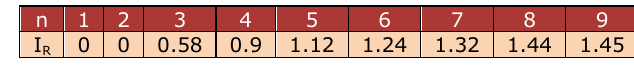
Table 3 . Coincidence index of judgment